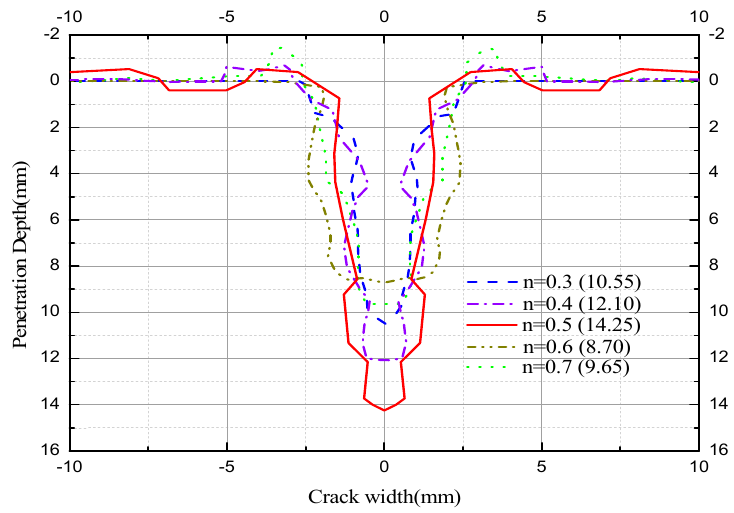
Figure 15. Penetration depth of BLSCs with different ratios of small to all apex angles.